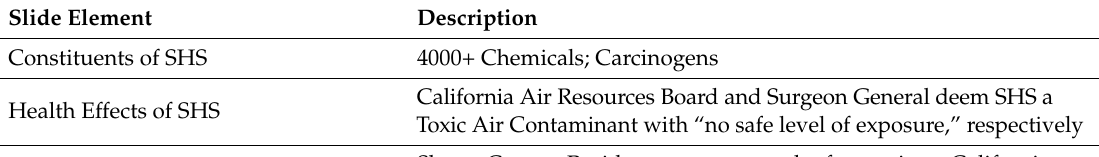
Table 2. Elements of slide presentation by general manager to tribal